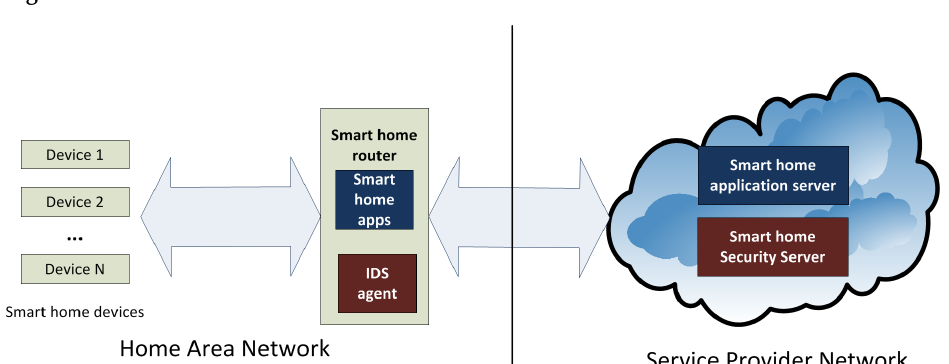
Figure 3. Basic IDS architecture.